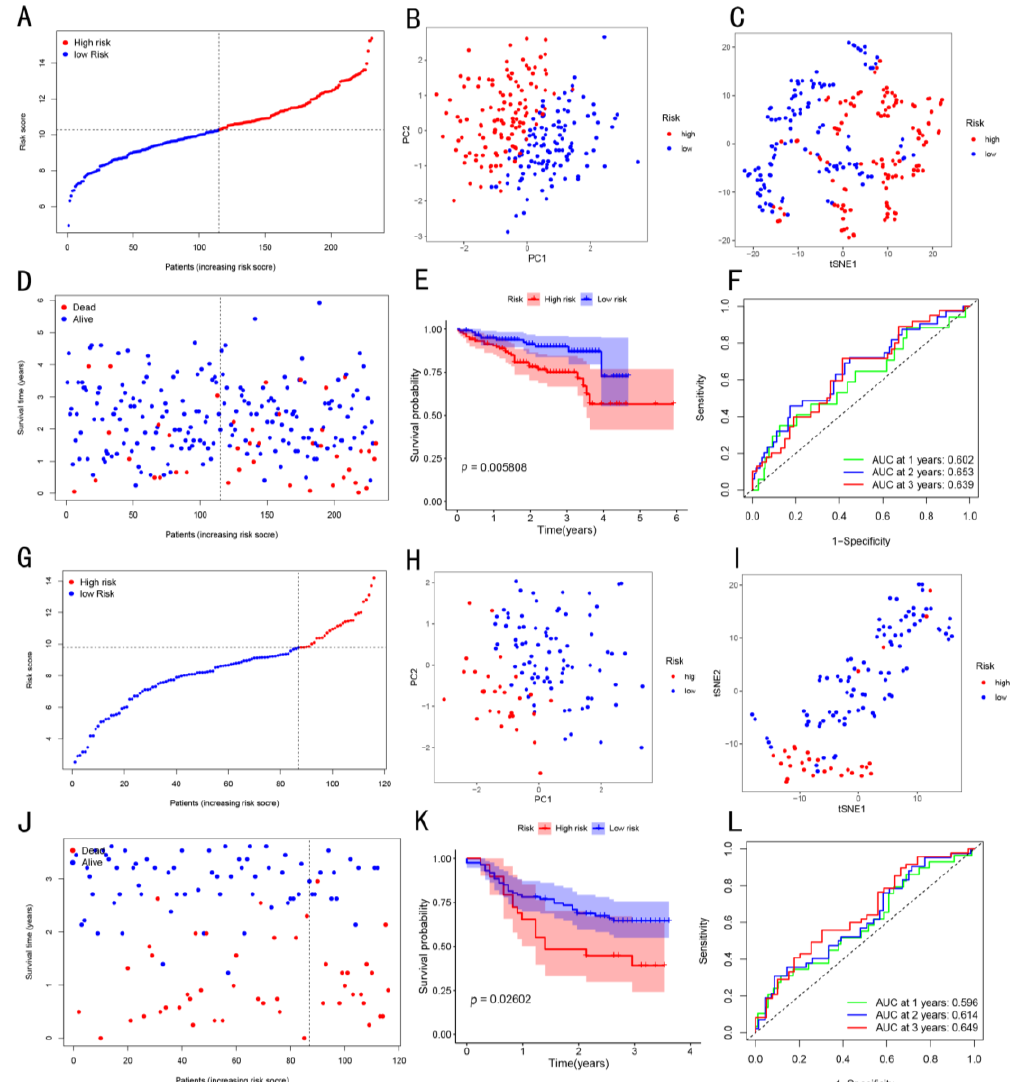
Figure 4. Validation of the four-gene signature using the ICGC cohort data and our in-house cohort data (named as an in-house cohort). ( A – F ) and ( G – L ) are the analyses of the ICGC cohort and our in-house cohort data, respectively. ( A ) Risk curves, showing the distribution of sample risk values in the ICGC cohort. ( B ) PCA analysis of high- and low-risk groups in the ICGC cohort. ( C ) t-SNE analysis of two groups performed in the ICGC cohort. ( D ) Survival status vs. time in the ICGC cohort. ( E ) K – M curve for the two groups of patients in the ICGC cohort. ( F ) Time-dependent ROC curve of risk score prognostic performance in the ICGC cohort. ( G ) Risk curves, showing the distribution of sample risk values in the in-house cohort. ( H ) PCA analysis of the high- and low-risk groups in the in-house cohort. ( I ) t-SNE analysis of two groups performed in the in-house cohort. ( J ) Survival status vs. time in the in-house cohort. ( K ) K – M curve for two groups of patients in the in-house cohort. ( L ) Time-dependent ROC curve of risk score prognostic performance in the in-house cohort.